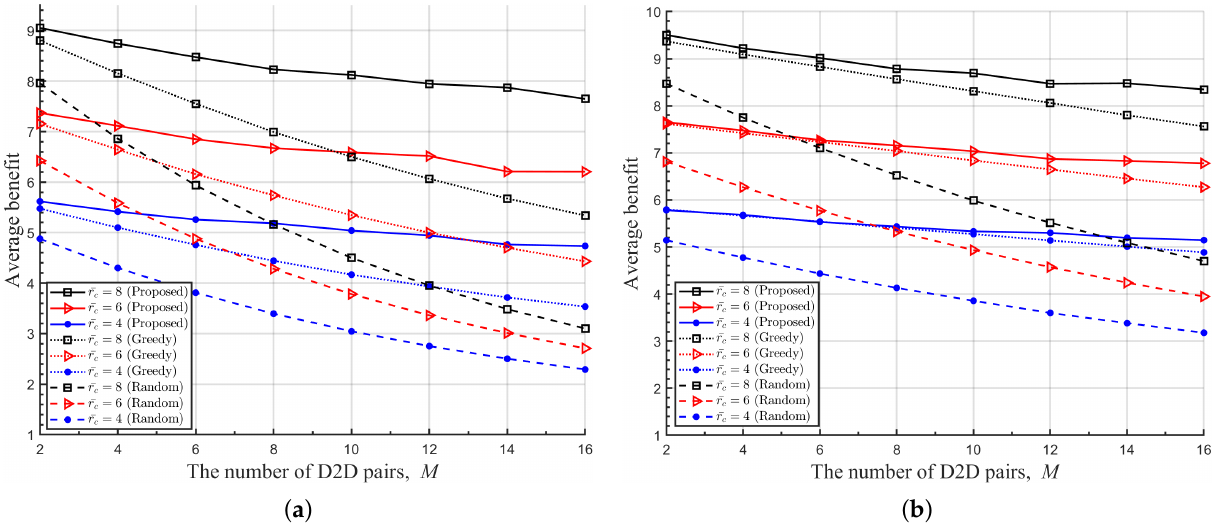
Figure 7. Average benefit of the proposed and other RA schemes with respect to M for various R c .